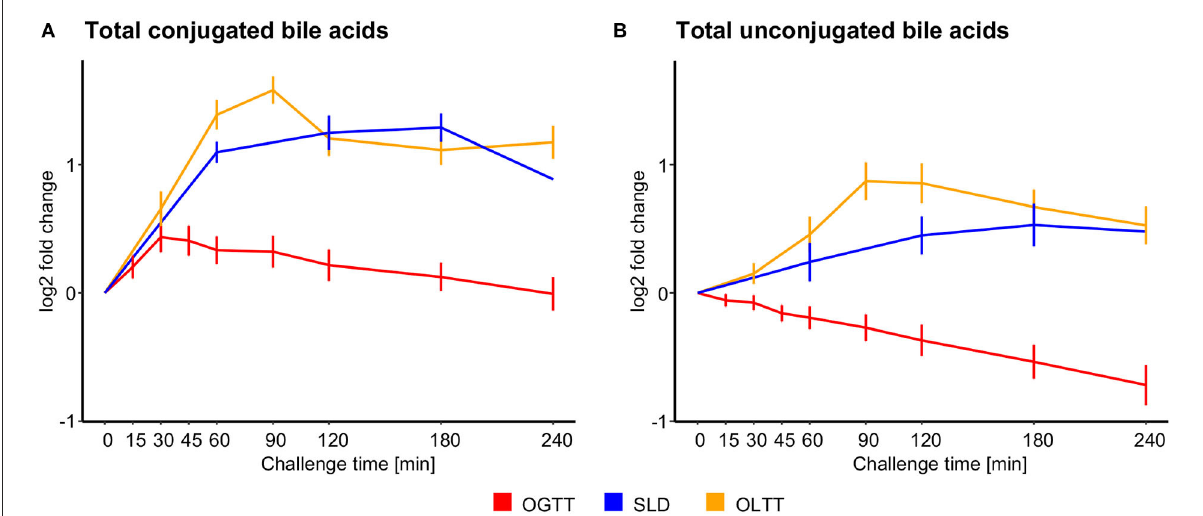
FIGURE3 Temporal plots of sums of conjugated and unconjugated bile acids. Bile acids that exhibited significant temporal changes in at least one of the challenges were split into unconjugated ( n = 6) and conjugated ( n = 3) compounds. For each group, we calculated the total sum of abundances (based on normalized ion counts). (A) Log 2 fold changes in the sum of conjugated bile acids ± the standard error of the mean (SEM) after the ingestion of the different challenge drinks. (B) Log 2 fold changes in the sum of unconjugated bile acids ±